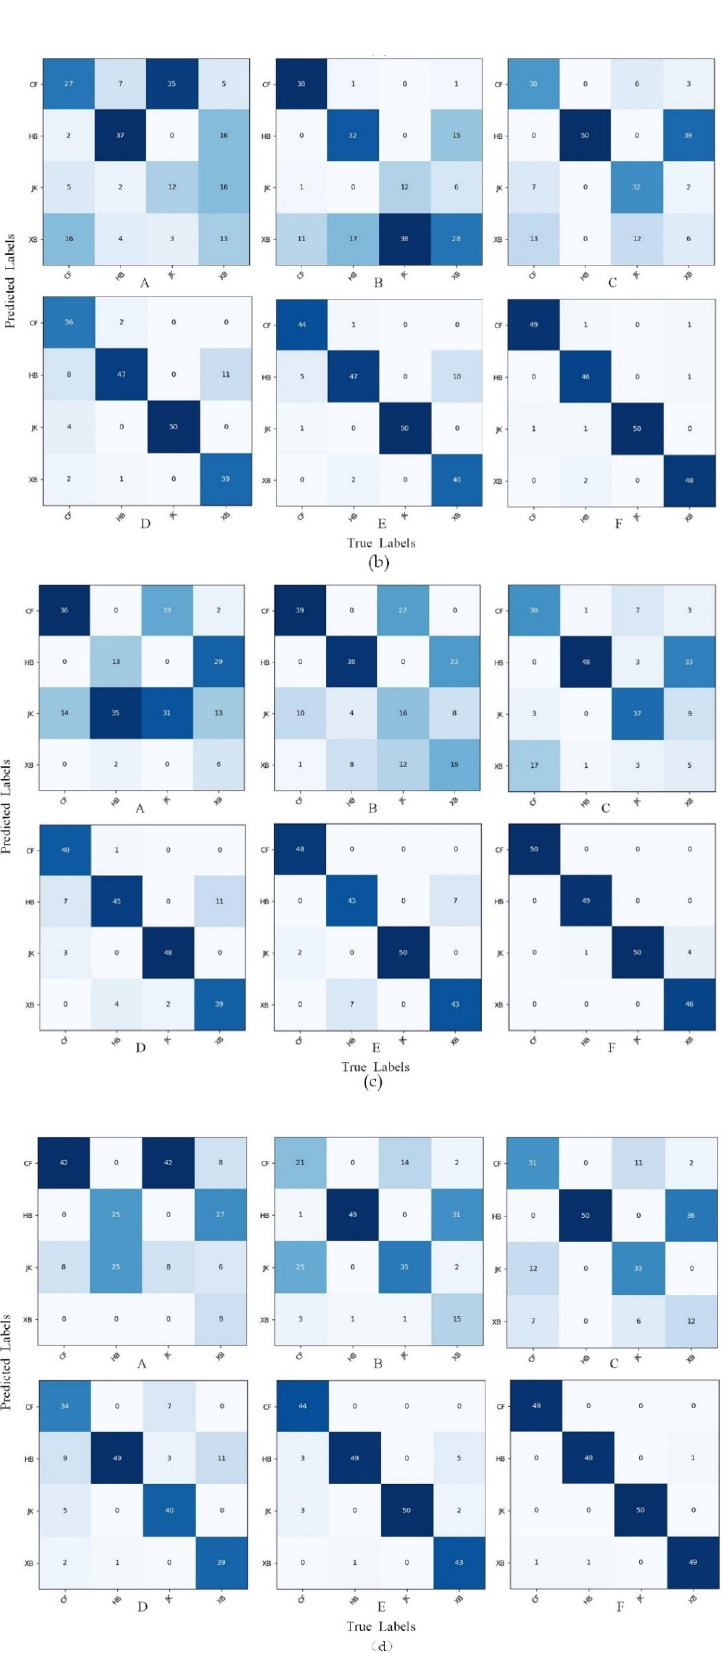
Figure 11. Confusion matrix of the four image recognition networks: ( a ) MobileNetV3-Large, ( b ) Alexnet, ( c ) Resnet, and ( d ) Densenet. (Explanations of A–F): A, original dataset; B, original dataset with supervised data augmentation; C, original dataset with DCGAN